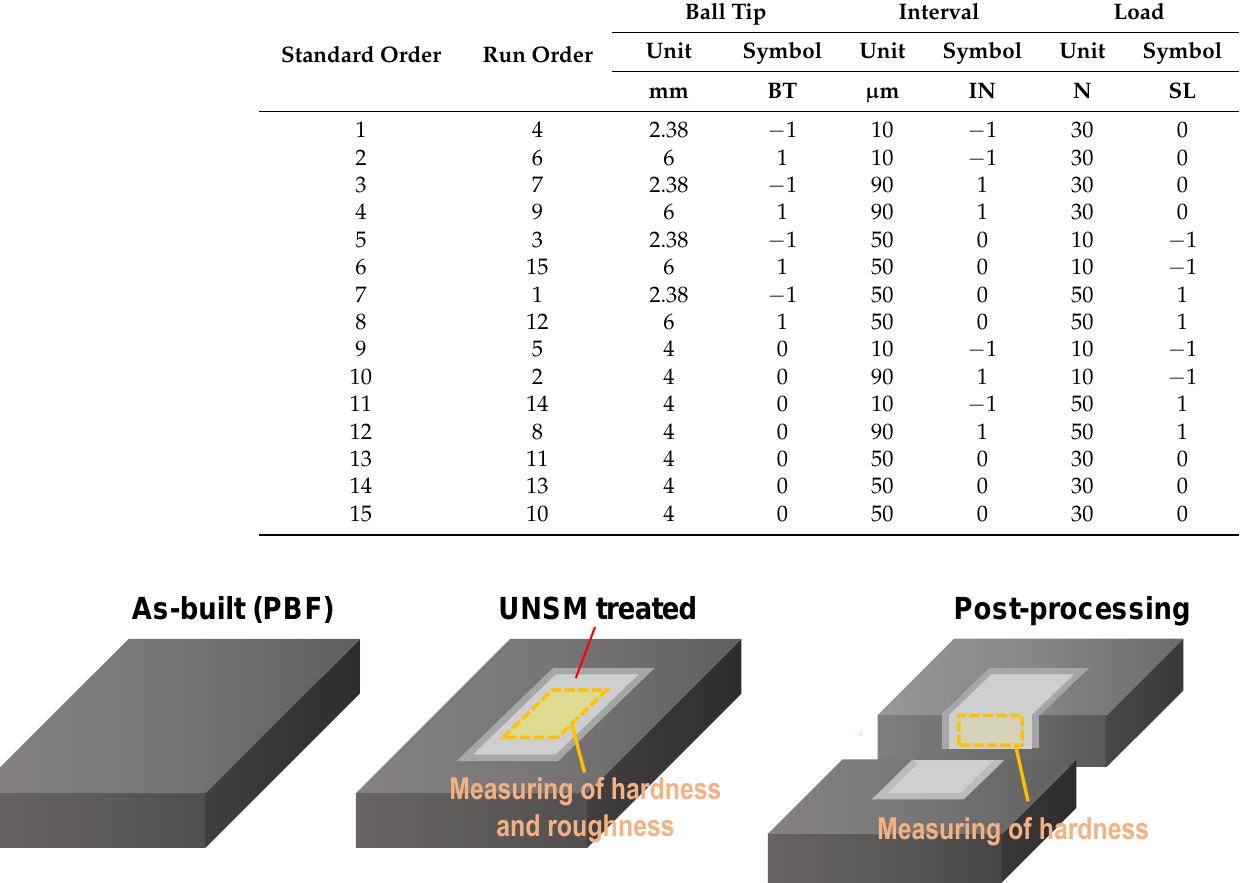
Figure 3. Preparation of specimens for measurement of hardness and roughness.